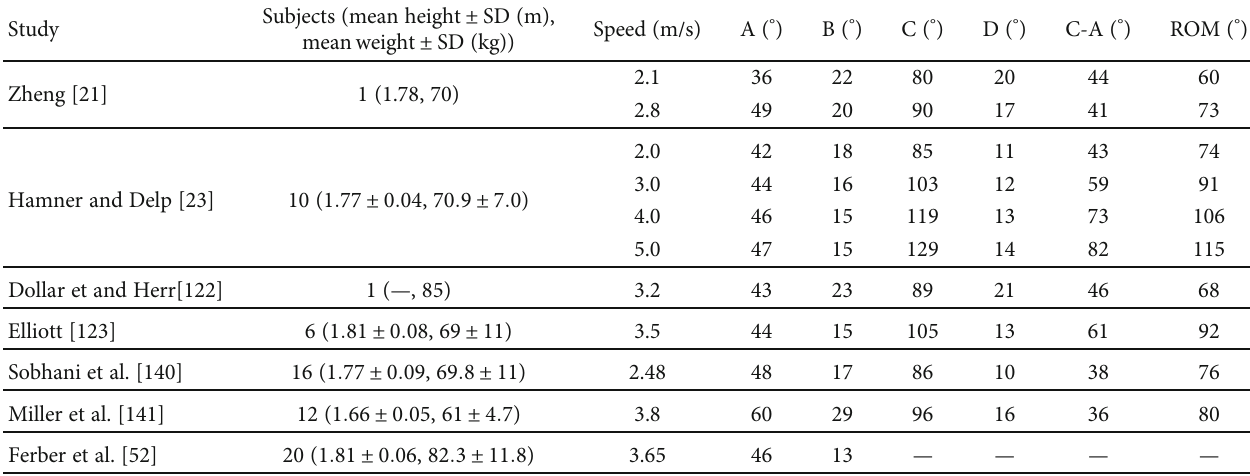
Figure 3: A sketch map of motion and the typical curves of knee angle, moment, and power in the sagittal plane for a running cycle. (a) Sketch map of running motion [14]. (b) Knee angle-time curve ((A) fi rst peak knee fl exion angle, (B) fi rst peak knee extension angle, (C) second peak knee fl exion angle, and (D) second peak knee extension angle). (c) Knee moment-time curve ((E) fi rst peak knee extension moment, (F) fi rst peak knee fl exion moment, (G) second peak knee extension moment, and (H) second peak knee fl exion moment). (d) Knee power-time curve ((I) fi rst peak knee absorption power, (J) fi rst peak knee generation power, (K) second peak knee absorption power, and (L) third peak knee absorption power) [23, 122, 123]. Table 4: Overview over the experimental results of knee angle for